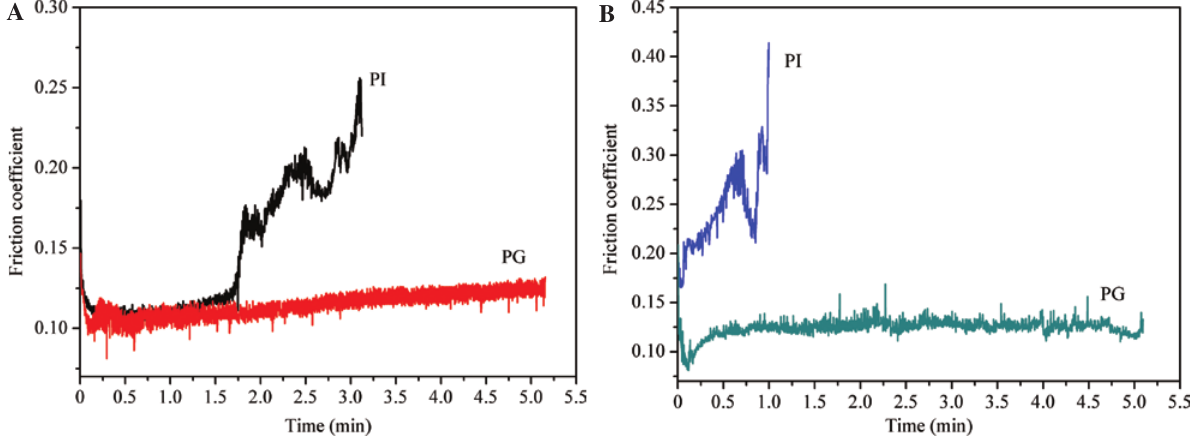
Figure 8: Variation of the friction coefficients of PI and PG composite with sliding time under the temperature of 400 ° C (A: 500 N applied load; B:700 N applied